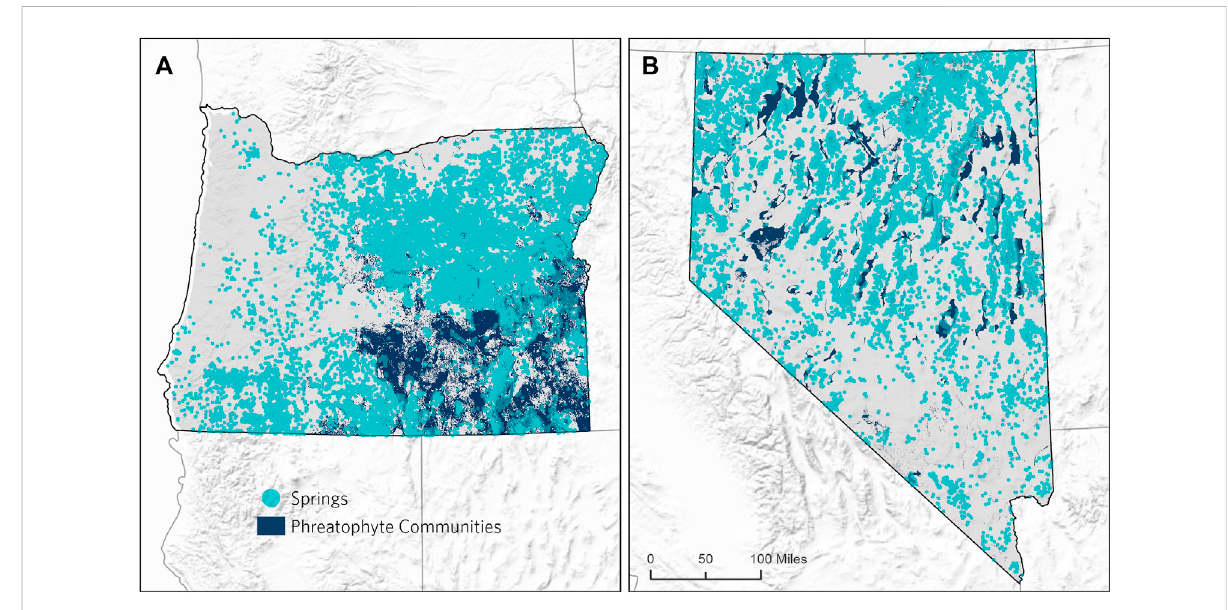
FIGURE 1 Statewide distribution of groundwater-dependent ecosystems assessed in this study in (A) Oregon ( n = 29,379 springs and n = 682,136 ha phreatophyte communities) and (B) Nevada ( n = 25,194 springs and n = 2,171,800 ha phreatophyte